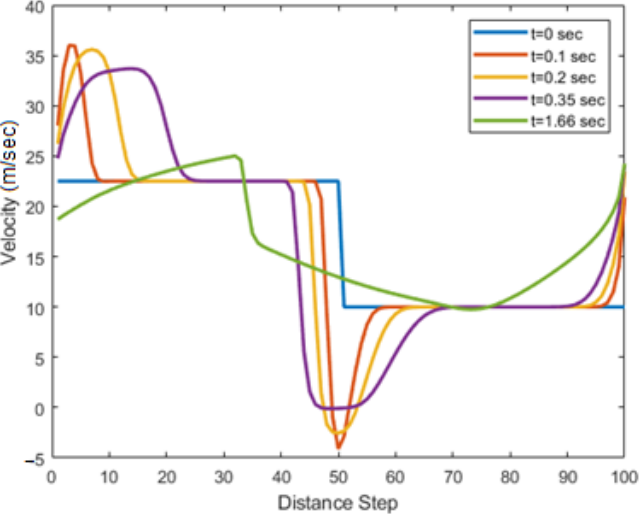
Figure 16. Velocity behavior of the PW model on a ring road.